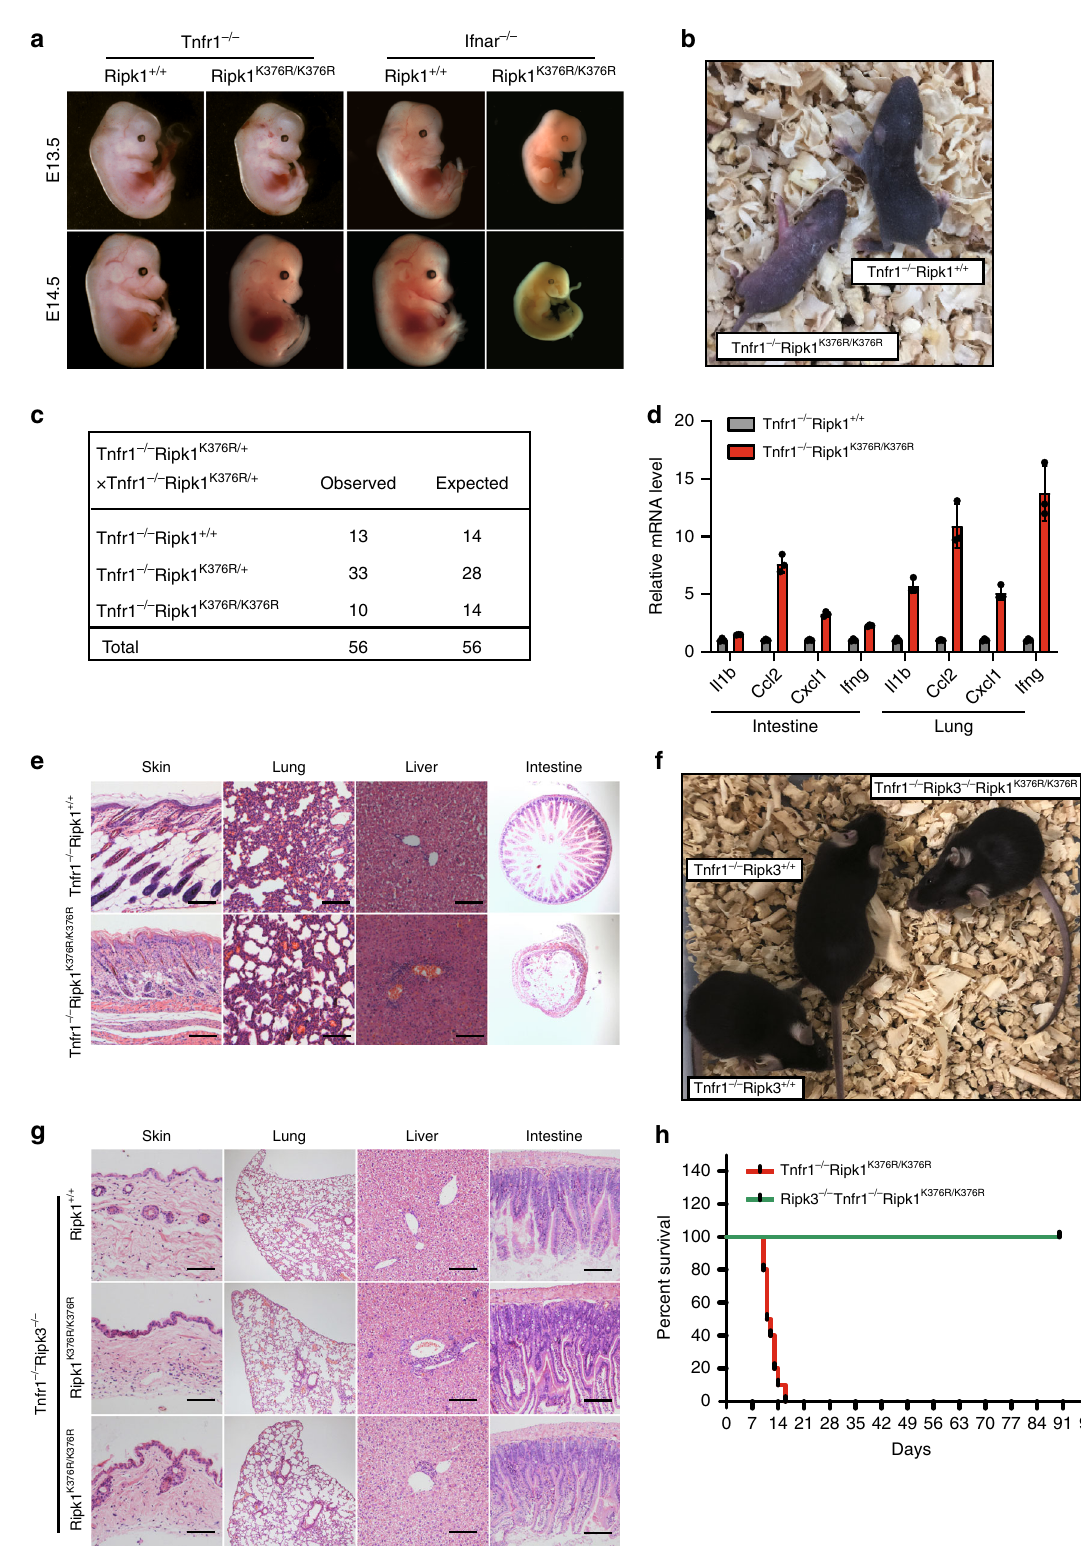
in peripheral lymphoid organs seen in Ripk3 − / − Fadd − / − and Mlkl − / − Fadd − / − mice (Fig. 7d, f, Supplementary Fig. 4d) 19 – 22,41 – 43 . The disease was characterized by lymphadenopathy and splenome- galy, which disrupted the normal architecture of the lymph nodes and spleen (Fig. 7c, d). Flow cytometric analysis revealed profoundly increased numbers of multiple cells in spleen and lymph